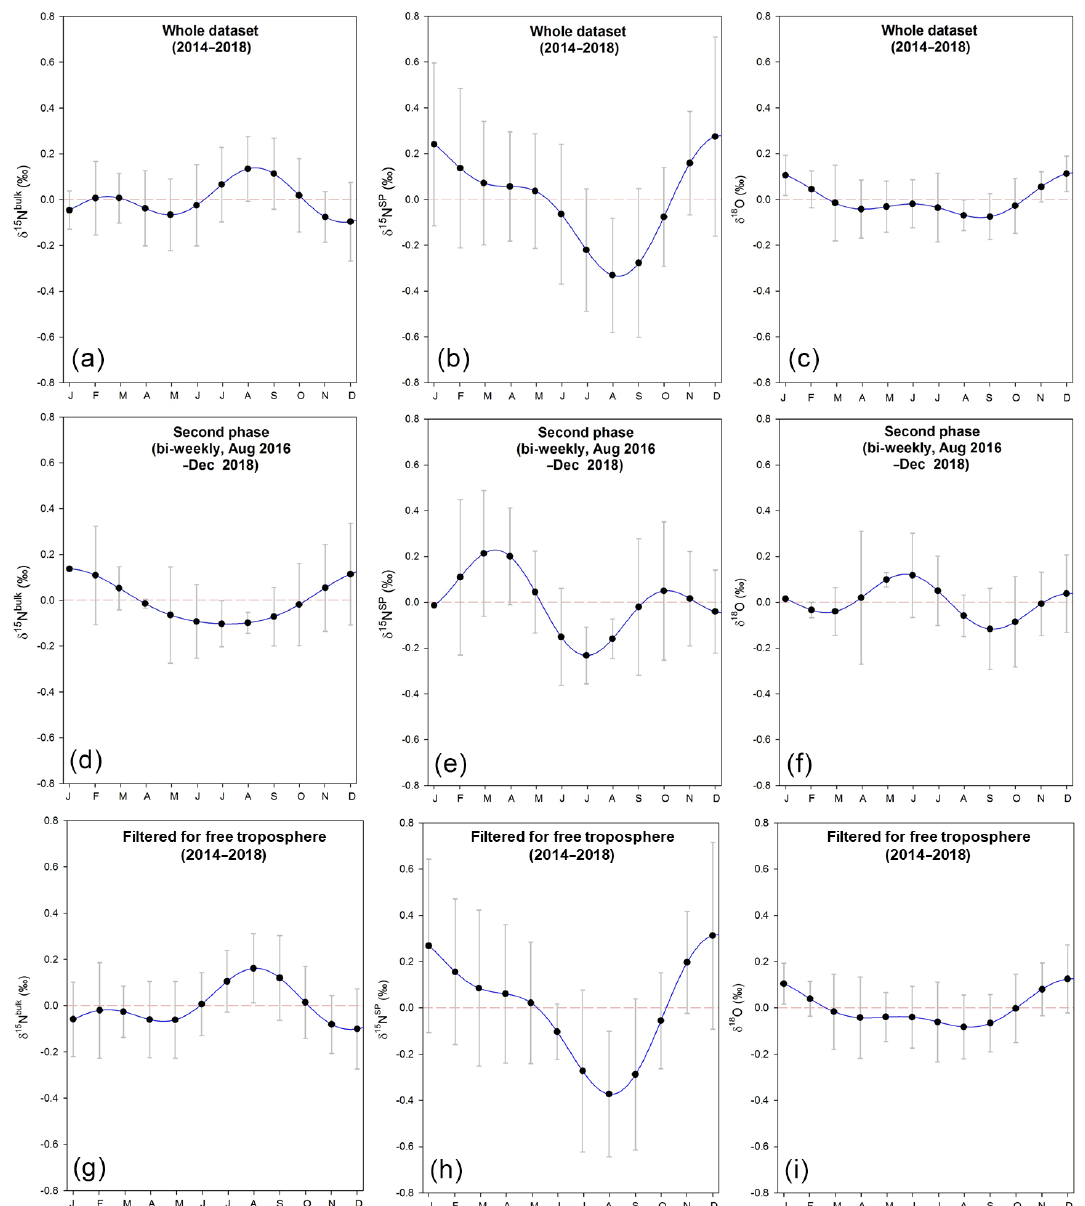
Figure 3. Seasonality of isotopic signatures of atmospheric N 2 O observed at Jungfraujoch. (a–c) Seasonality obtained using the whole dataset from April 2014 to December 2018; (d–f) seasonality obtained using bi-weekly data collected between August 2016 and December 2018; (g–i) seasonality obtained using dataset filtered for free troposphere from April 2014 to December 2018. Dashed red lines refer to zero variability. The NLS model simulation for time series gives the detrended seasonality, with error bars indicating 1 standard deviation of monthly